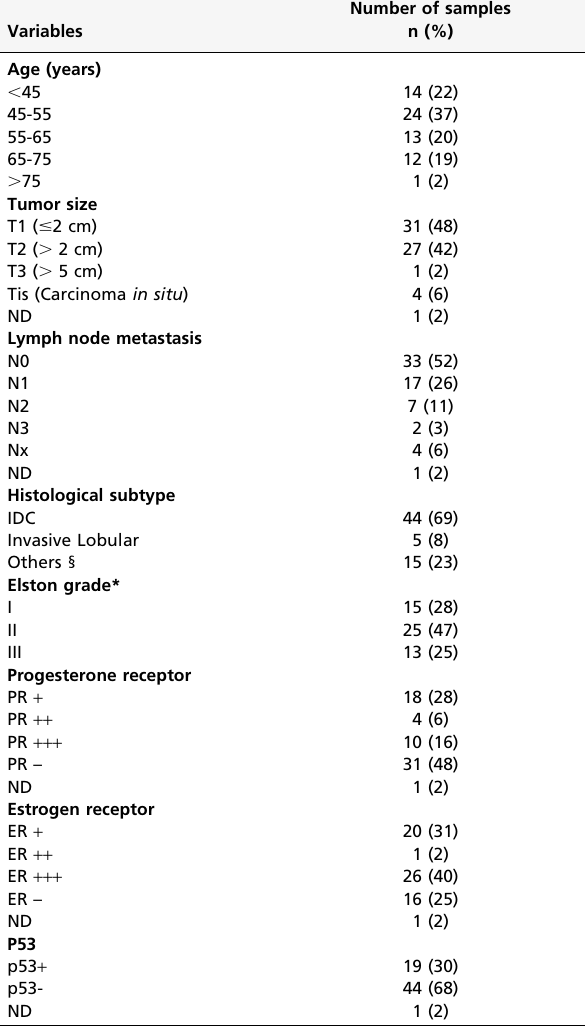
Supplementary Table 3 - Classification of cases according to the clinical-pathological aspects (total =